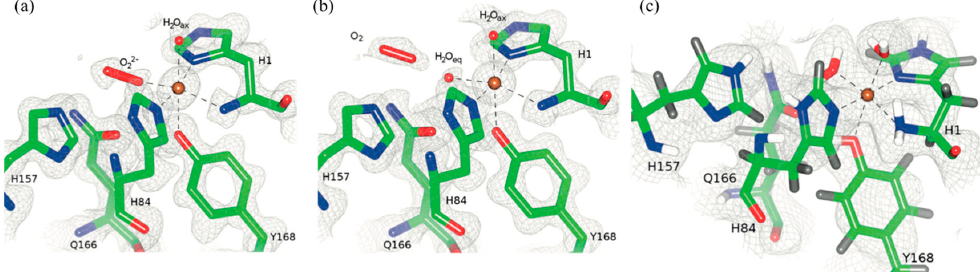
Figure 15. Cu-binding site and coordination in different crystal structures of LPMO from Neurospora crassa . ( a ) X-ray structure of crystal treated with ascorbate, peroxo (O 22 − ) bound; ( b ) X-ray structure of crystal treated with ascorbate, molecular oxygen (O 2 ) bound in “pre-bound” position; ( c ) neutron structure with His157 modeled as neutral and pointing at “pre-bound” position. Figure reproduced with permission from [51].